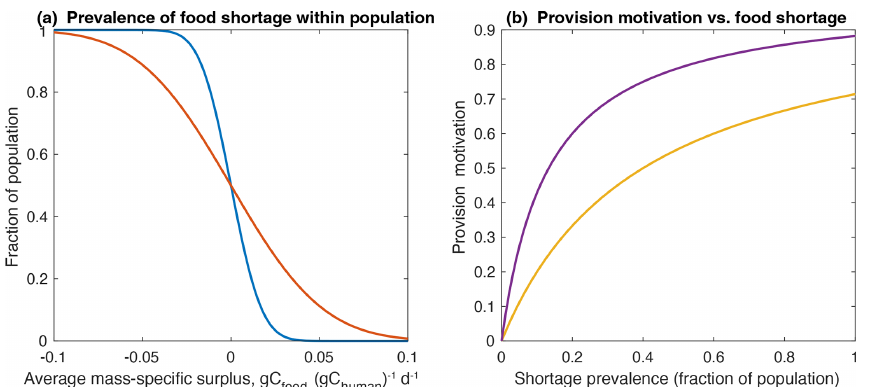
Figure 4. Food shortage and provisioning motivation. Panel (a) shows the fraction of population experiencing food shortage for two values of σ . A larger value of σ corresponds to greater inequality (red) compared to the value used in the simulations (blue). Panel (b) shows the population motivation factor for provisioning as a function of the shortage fraction. The relative motivation strength is shown for highly responsive (low k , purple) and weakly responsive (high k , yellow)